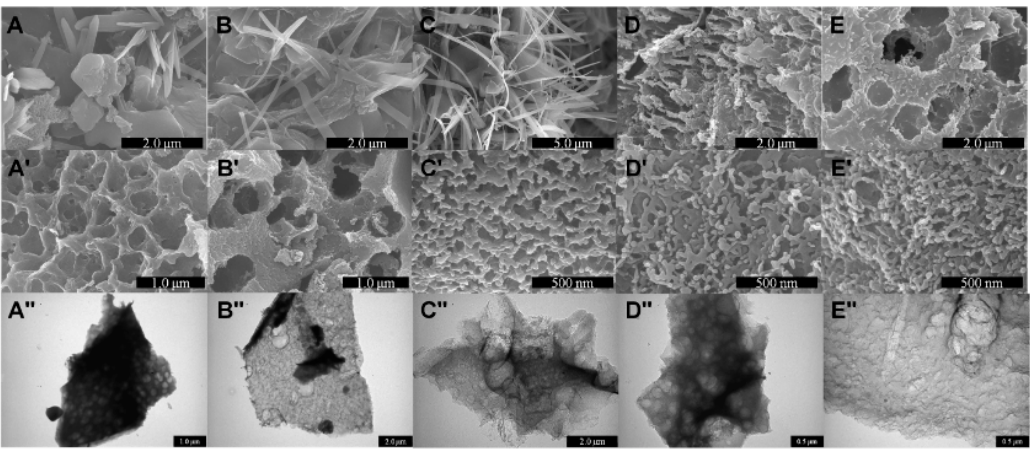
Figure 2. Effect of carbonization temperature on the formation or porous carbonaceous materials from human urine. SEM images of the mixture of carbon rock salts obtained at URC-X-BW, where X is ( A ) 700; ( B ) 800; ( C ) 900; ( D ) 1000, and ( E ) 1100 before washing with diluted HCl. Whereas ( A ′ ) SEM and ( A ′′ ) TEM images of URC-700; ( B ′ ) SEM and ( B ′′ ) TEM images of URC-800; ( C ′ ) SEM and ( C ′′ ) TEM images of URC-900; ( D ′ ) SEM and ( D ′′ ) TEM images of URC-1000; and ( E ′ ) SEM and ( E ′′ ) TEM images of URC-1100 after HCl washing, demonstrating the porous morphology of carbon obtained after the HCl treatment.